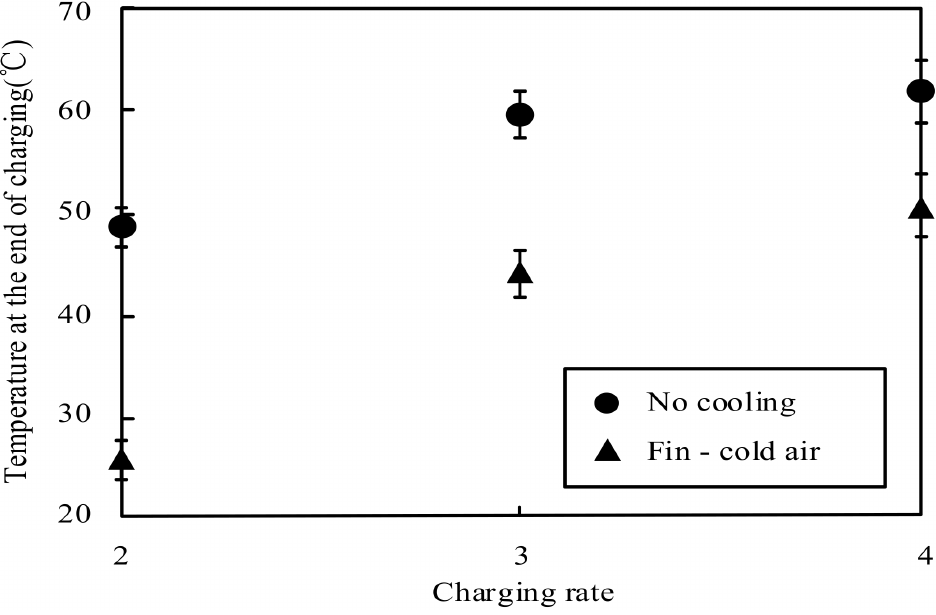
Figure 8. Finned air-cooling effect at different charging